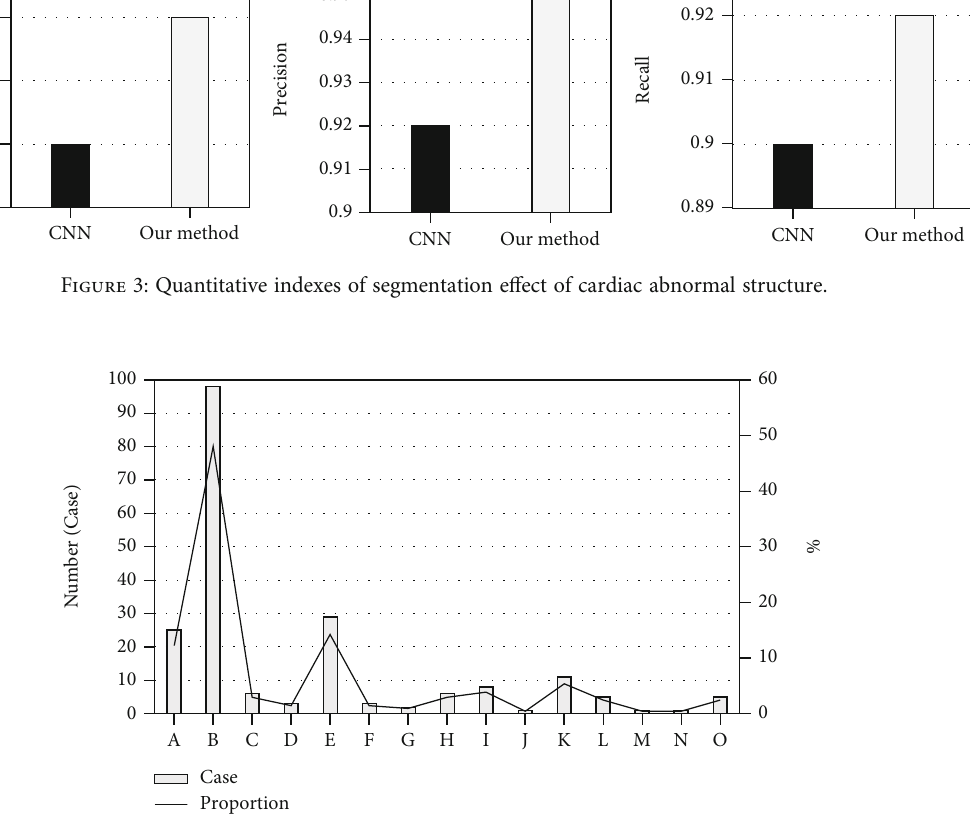
Figure 4: The disease type distribution of CHD in fetuses. (a) Persistent left superior vena cava. (b) Ventricular septal defect. (c) Single ventricle. (d) Single atrium. (e) Abnormal right subclavian artery. (f) Transposition of the great arteries. (g) Interrupted aortic arch. (h) Aortic coarctation. (i) Right-sided arcus aortae. (j) Absence of inferior vena cava. (k) Pulmonary artery stenosis. (l) Endocardium pad defect. (m) Persistent truncus arteriosus. (n) Pulmonary artery atresia. (o) Double-outlet right ventricle.